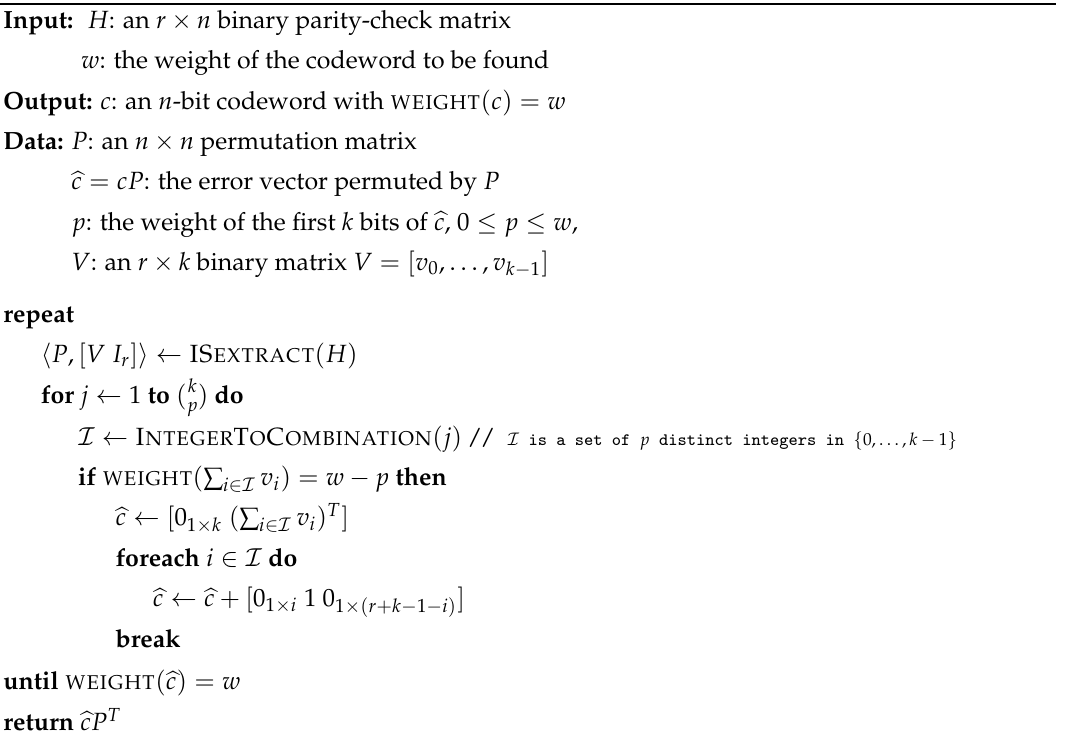
Algorithm 3: Codeword finding formulation of Lee and Brickell’s